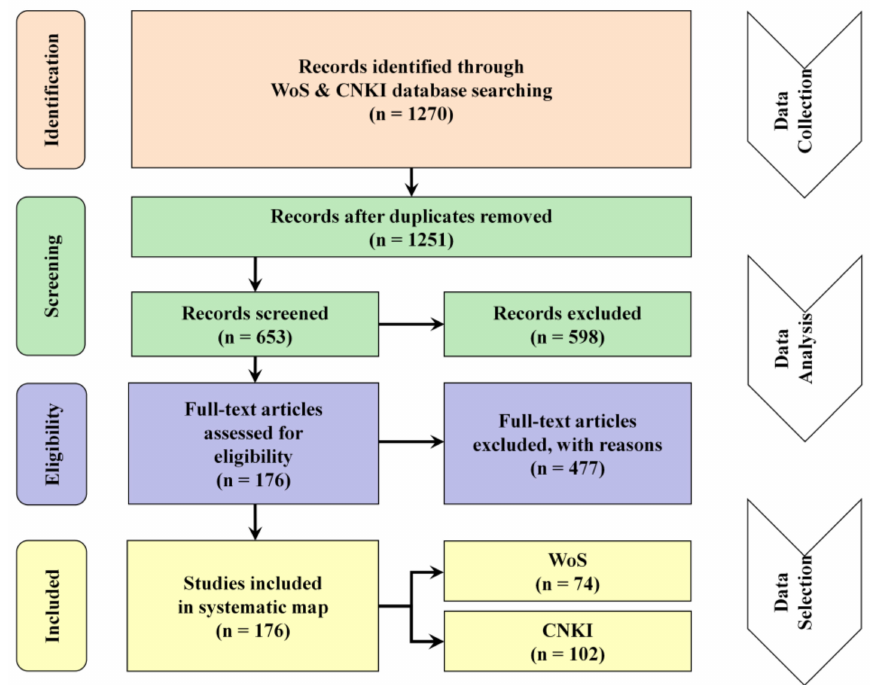
Figure 2. Data selection process. The articles satisfying the eligibility criteria were included in the study. Articles were excluded if they were studies on forest fire restoration, urban traffic pollution, urban landscape, remote sensing information technology, animals,